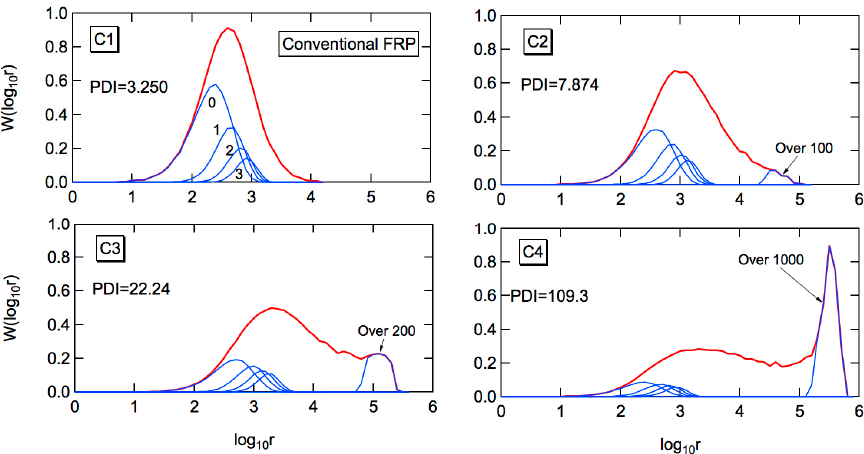
_ _ w / r n . The PDIs are the theoretical